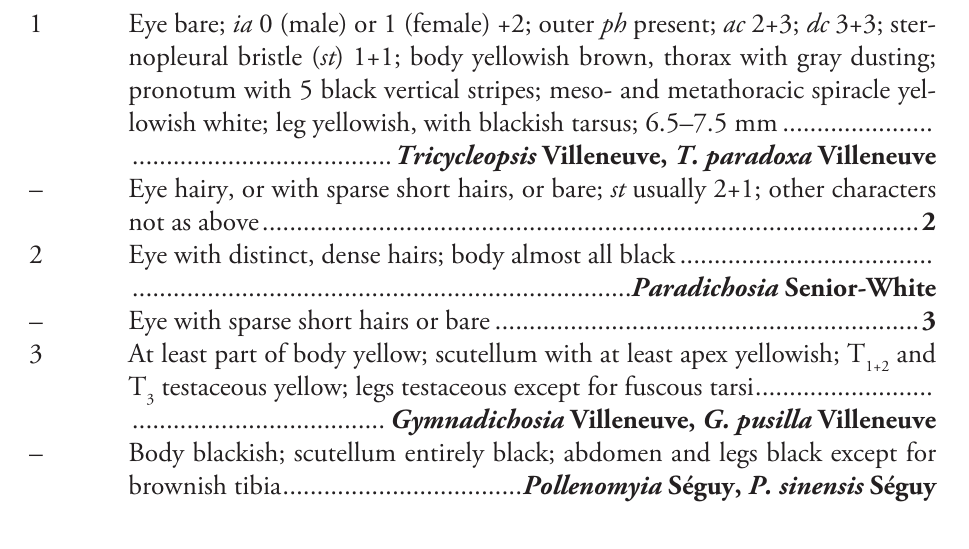
Hind tibia with submedian anterodorsal bristle ( ad ) more than 3 times as long as tibial diameter; hind tarsus with dorsal hairs longer than usual, form- ing a short fringe; third sternite (ST ) of male with tuft of long hairs ............ 3 Submedian ad of hind tibia no more than 3 times as long as tibial diameter; dorsal hairs of hind tarsus not longer than usual; male ST with tuft of 3